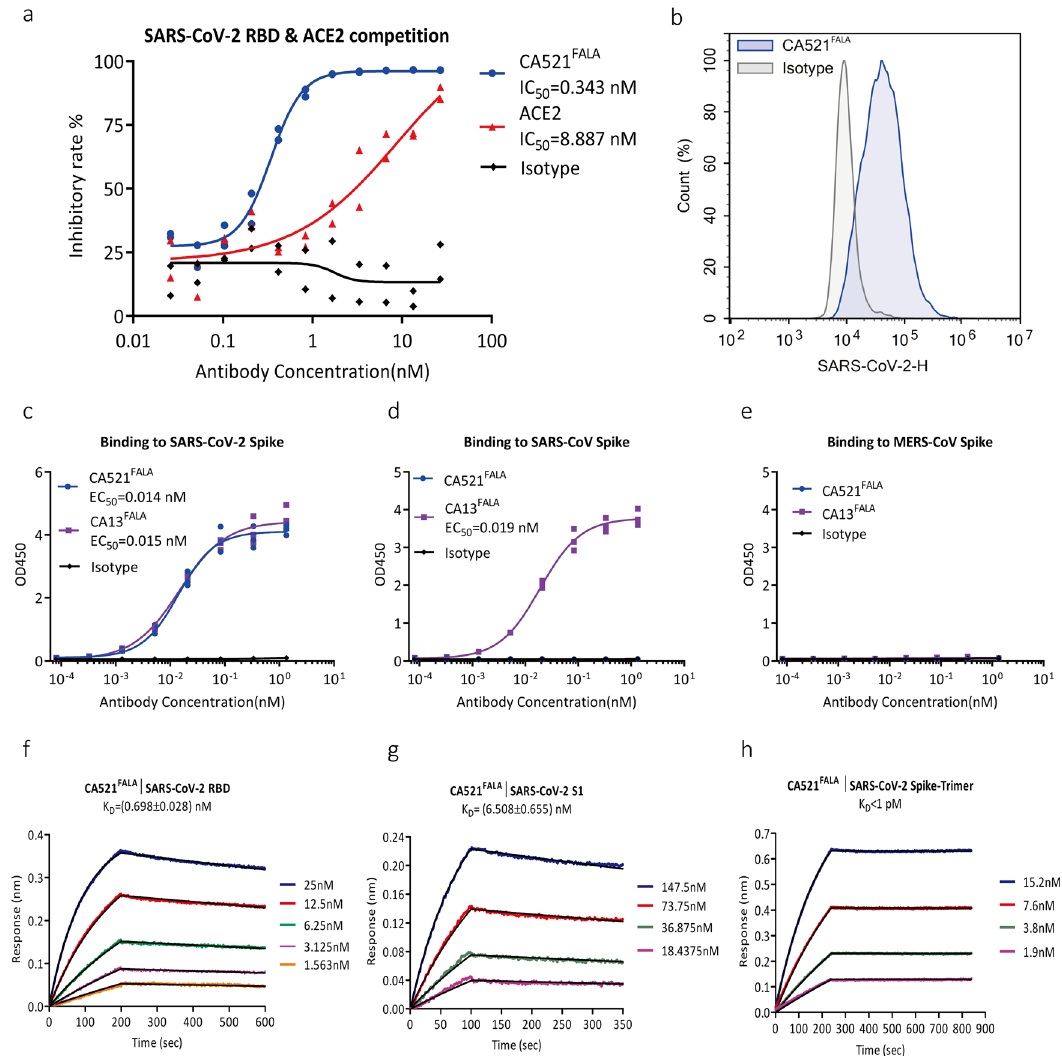
Fig. 1 CA521 FALA can block the binding of SARS-CoV-2-RBD to hACE2 receptor and speci fi cally bind Spike of SARS-CoV-2. a CA521 FALA can effectively block RBD binding to ACE2 receptor in ELISA. CA521 FALA and hACE2 protein can block the binding of SARS-CoV-2 RBD and hACE2 with IC50 of 0.343 and 8.887 nM, respectively. Experiments were performed in duplicate, value = mean ± SD. b CA521 FALA could speci fi cally bind to CHO-K1 cells expressing SARS-CoV-2 Spike. SARS-CoV-2 Spike protein transfected CHO-K1 cells were stained with isotype control, CA521 FALA at a concentration of 0.74 μ g/mL. FITC-anti-HuFc secondary antibody was used for fl ow cytometry. Irrelevant mAb with the same constant region of CA521 FALA was used as an isotype. Experiments were performed in triplicate and one representative data was displayed. c – e CA521 FALA could speci fi cally bind to SARS-CoV-2 Spike protein, but does not cross-react with SARS-CoV Spike or MERS-CoV Spike protein in Elisa. CA521 FALA binds SARS-CoV-2 Spike protein with EC50 of 0.014 nM. CA13, which is an anti- SARS-CoV-2 S2 domain mAb, can bind Spike of SARS-CoV-2 and SARS-CoV with EC50 of 0.015 and 0.019 nM. Experiments were performed in triplicate, value = Mean± SD. f – h The binding kinetics of CA521 FALA were assessed by biolayer Interferometry (BLI) assay using the Octet RED96 system (FortéBio). Trimer protein is from Shuimu BioSciences. Experiments were performed three times and one representative data was CA521 FALA with SARS-CoV-2-RBD, S1, and spike trimer